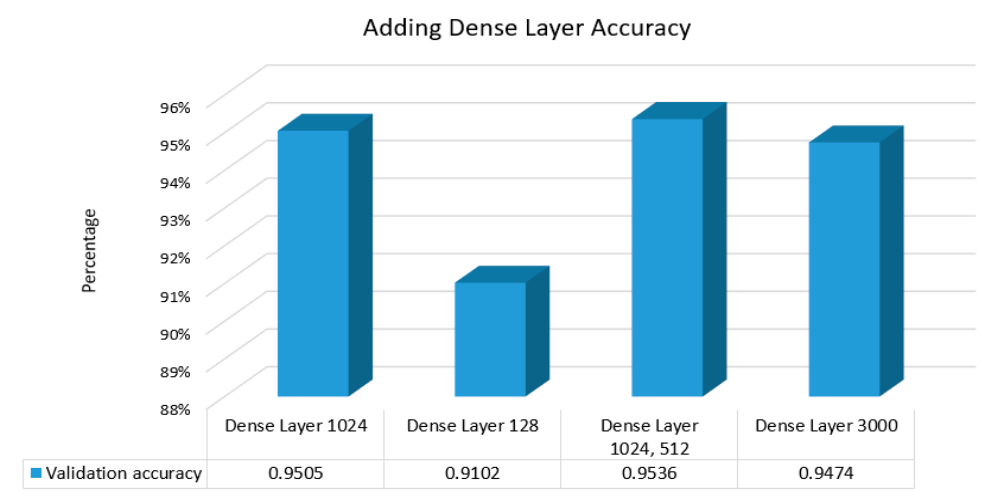
Figure 36. Dense layers performance.